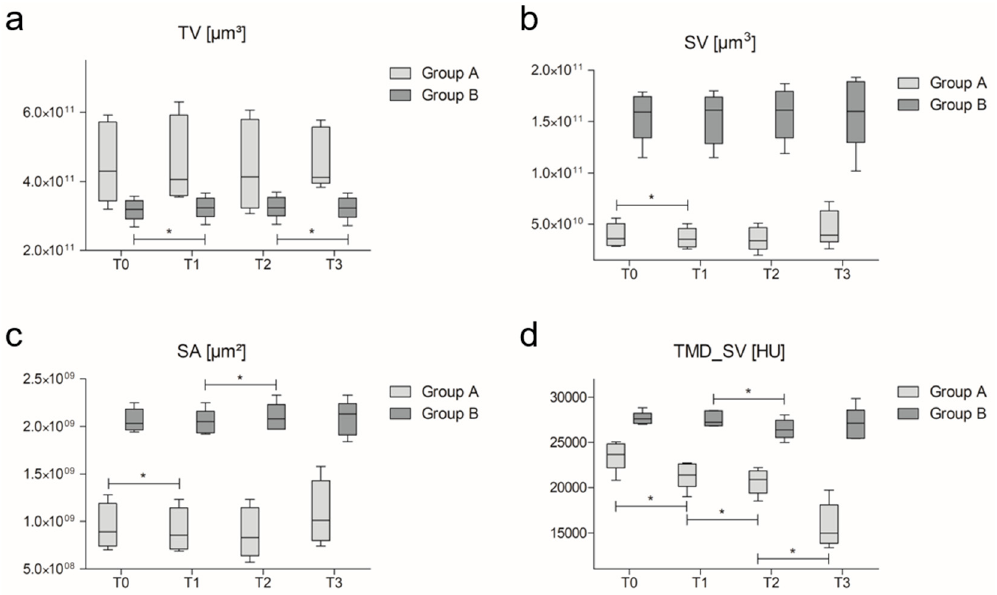
Figure 2. Data for the µCT-characteristics for TV ( a ) SV ( b ), SA ( c ), and TMD_SV ( d ) of the analyzed scaffolds (groups A and B) over time in Dulbecco’s Modified Eagle Medium (DMEM) (T0: initial scan at the beginning of the immersion period, followed by scans after seven (T1), 14 (T2), and 56 (T3) days in immersion), shown as boxplots (mean values with SEM and range). Significant changes over time are marked by (*).